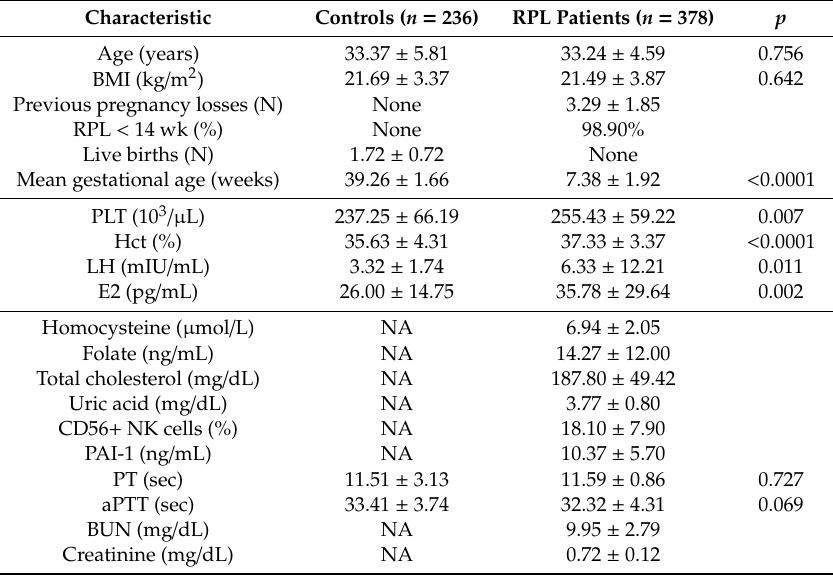
Table 1. Clinical characteristics of RPL patients and